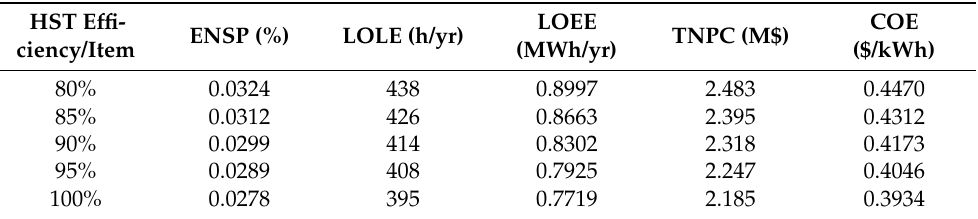
Table 11. Reliability and cost results in the sizing of HPV/FC energy systems using the IAEO and ENSP max = 5% considering different HST efficiency